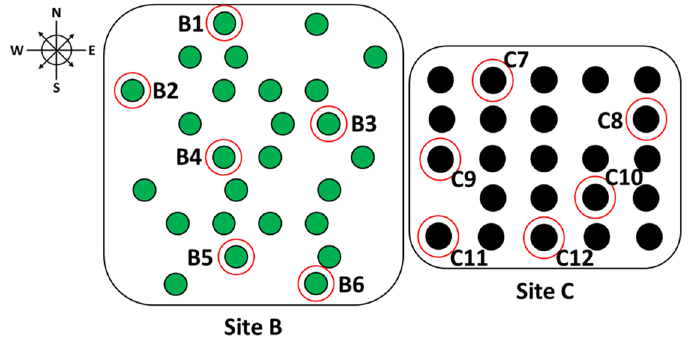
Figure 2. Sampling. A total of twelve samples were taken from Site B and Site C in 2017 after it was noted that Site B was healthy again and Site C had not recovered.